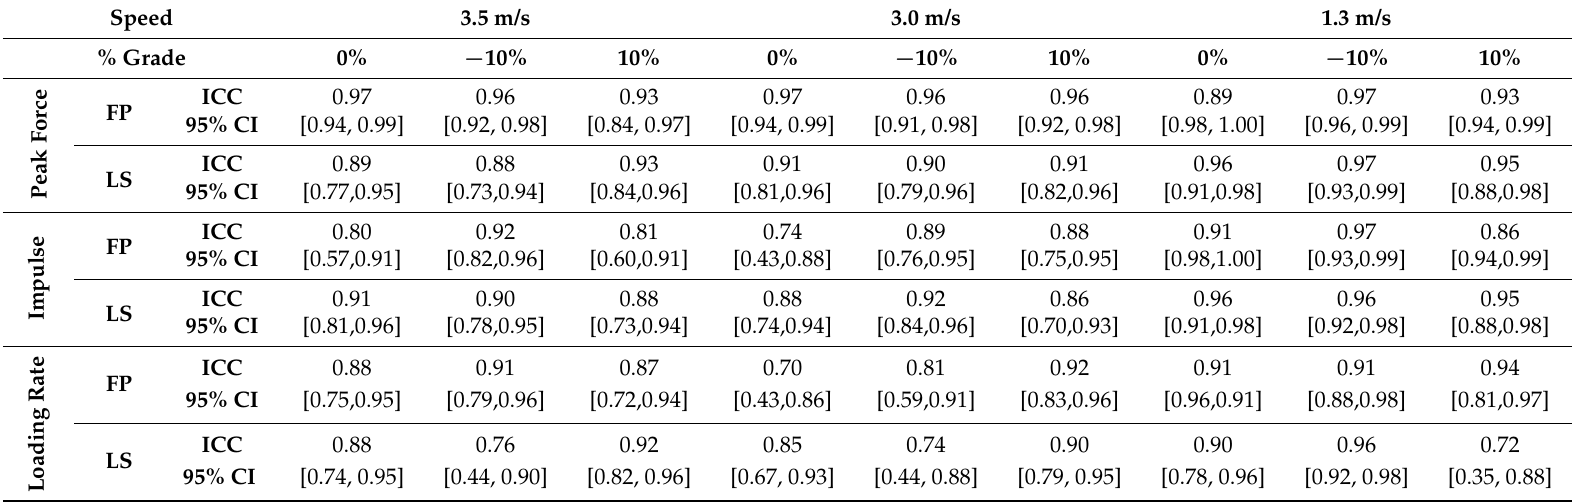
Table 4. Between-day reliability ICC and SEM values with the 95% confidence